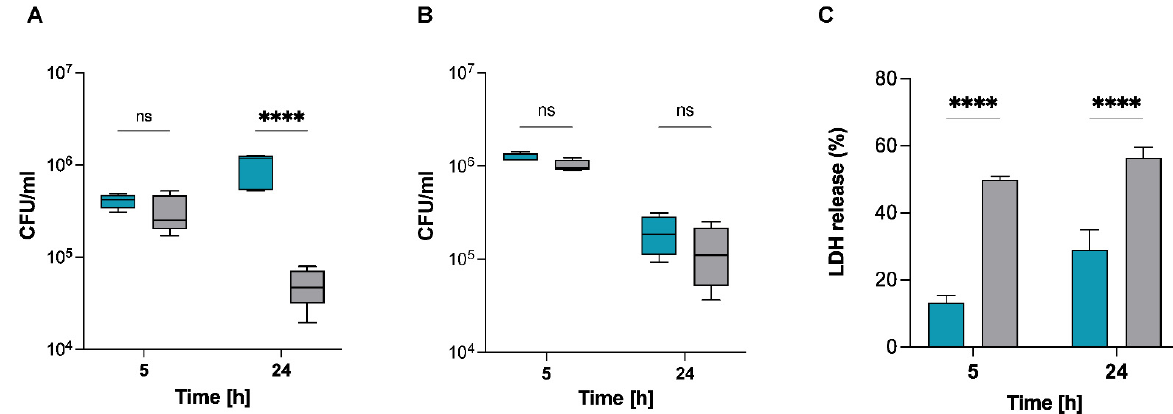
Figure 2. S. pettenkoferi SP165 survival in infected macrophages. S. pettenkoferi SP165 (blue) and S. aureus SA564 (grey) bacteria were used to infect RAW 264.7 ( A ) or THP-1 ( B ) macrophages. The amount of bacteria after 5 and 24 h pGt was evaluated after infection at a multiplicity of infection (MOI) of 20. The average and standard deviation (SD) of five different experiments are represented. ( C ) LDH release was measured using the CyQUANT assay kit after RAW 264.7 macrophage cells were infected at a MOI of 20 for 5 and 24 h, with the exception that the cells were seeded in a 96-well plate and that the extracellular bacteria were not eliminated. Data are expressed relative to the 100% positive control ( n = 3 biological repeats). A two-way ANOVA test was used to establish statistical significance, with ****, p < 0.0001; ns, not significant.